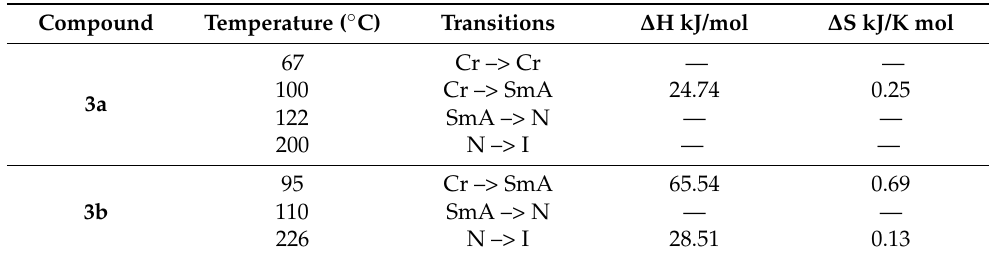
Table 4. Phase transition temperature. Reprinted/adapted with permission from Ref. [34]; published by JIARM, 2014. Compound